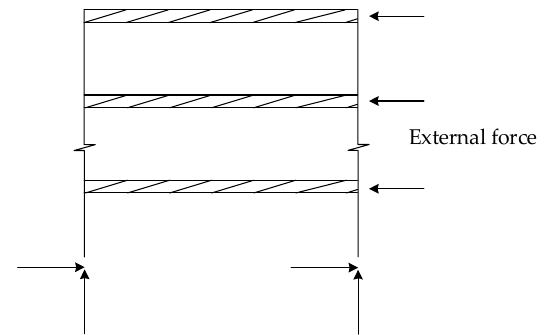
Figure 2. Illustration of the pseudo substructure.